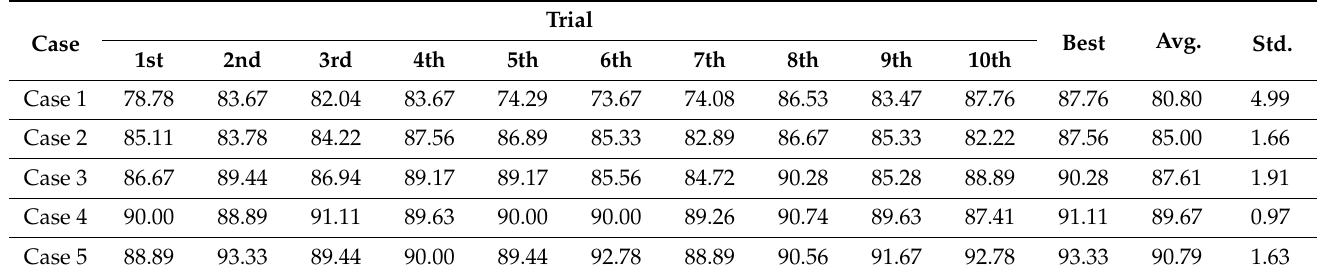
Table 2. Recognition accuracy with reference data solely for the comparative batch.